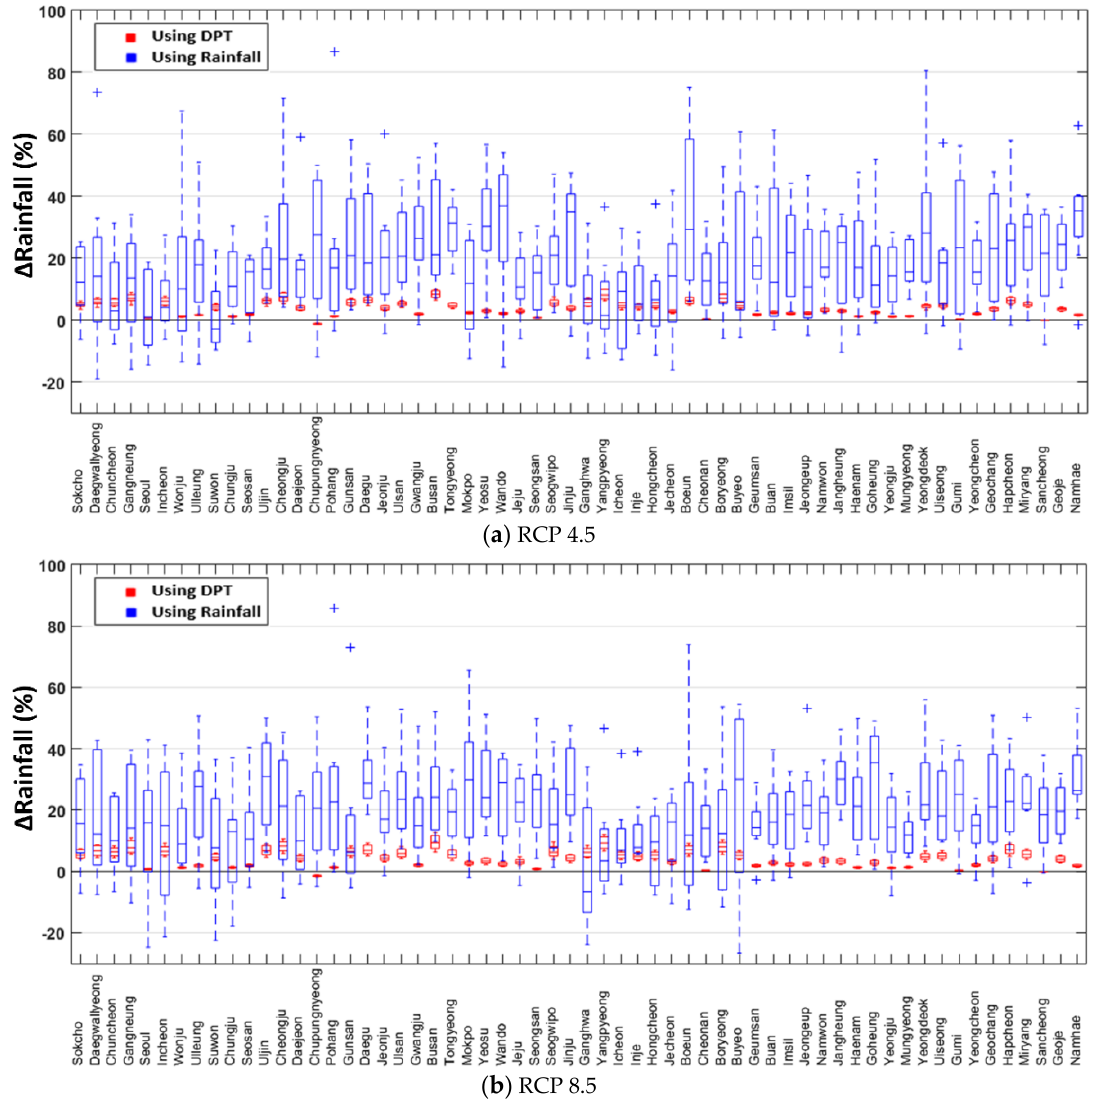
Figure 17. Change rate of future annual exceedance daily rainfall depth using DPT and rainfall data.